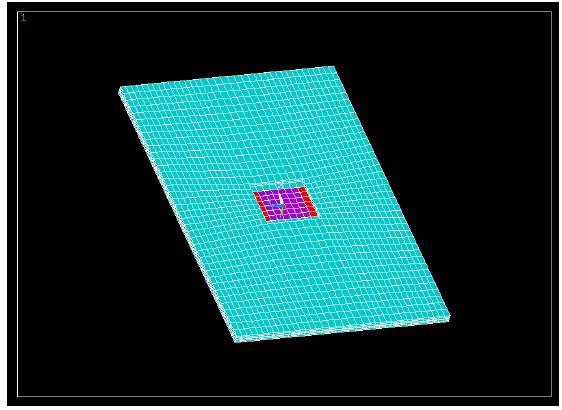
Figure 1. Numerical model of the AWS high fundamental frequency quartz crystal microbalance (HFF-QCM) 150 MHz sensor.